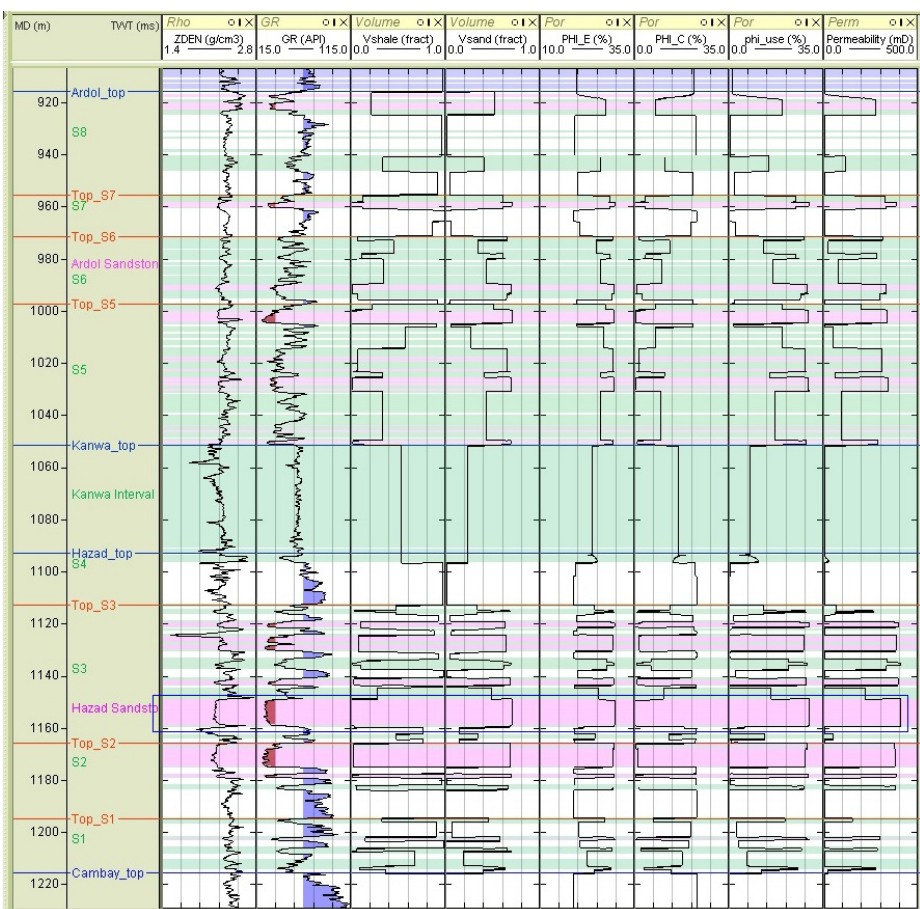
Fig. 5. Well logs of well (W1). Pure sandstone ( < 35 API) and shale ( > 65 API) are colored in red and blue on the gamma ray curve, respectively. Pink color bars and green color bars represent pure sandstone and shaly sand ( ≥ 35 API or ≤ 65 API), respectively. The zone highlighted by rectangles corresponds to a pure sandstone interval in the S3 layer that shows the highest permeability (409mD), which matches with the observed